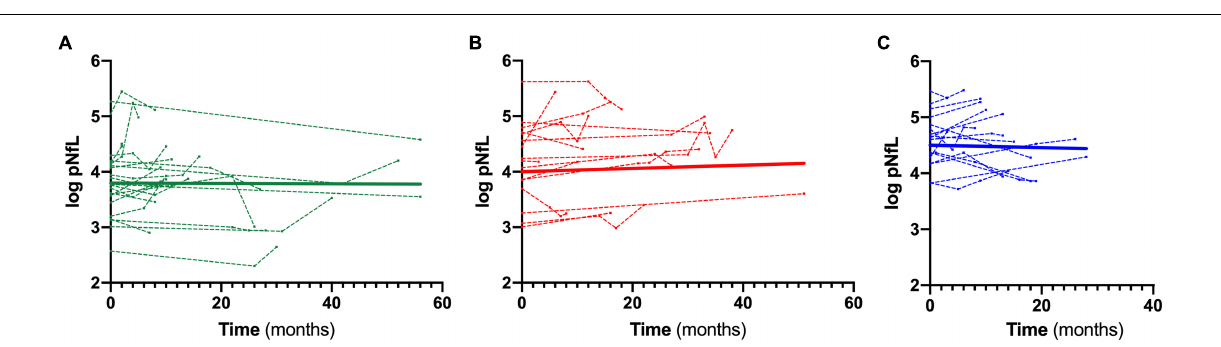
FIGURE 3 | Longitudinal trajectories of pNfL during the follow-up. Overall and single-patient longitudinal pNfL behavior in the slow (A) , intermediate (B) and fast (C) progressors showing a stable longitudinal biomarker trajectory Thick lines represent the overall biomarker trend. Analyses were conducted through a linear mixed effects model. Biomarker values are expressed in the logarithmic scale. Key: pNfL, plasma neurofilament light